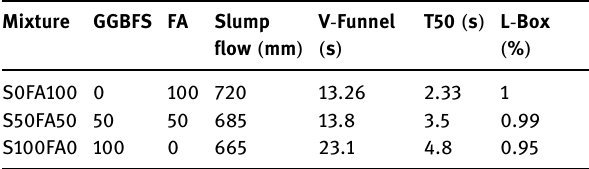
Figure 2: Slump fl ow diameter of SCGC.